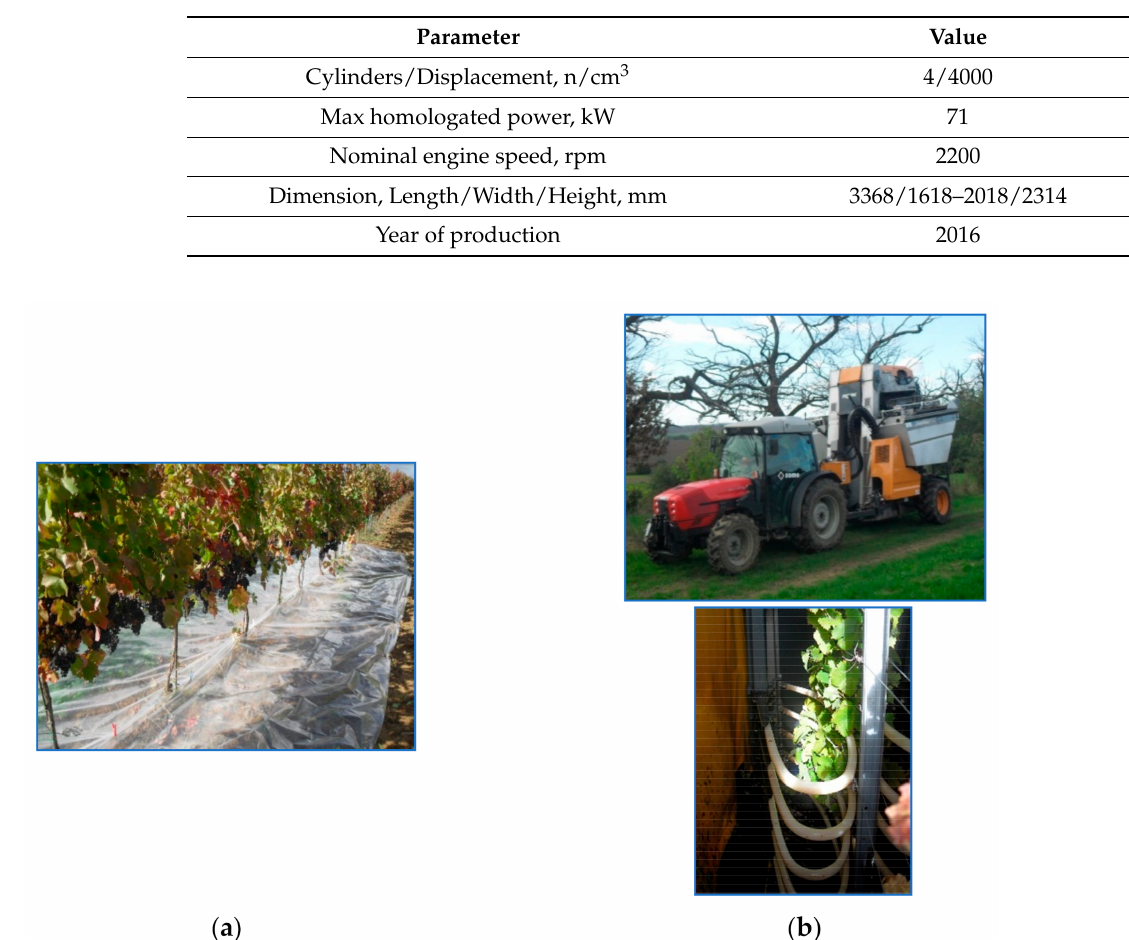
Table 3. Technical parameters of tractor Same Frutteto3 100 [20].